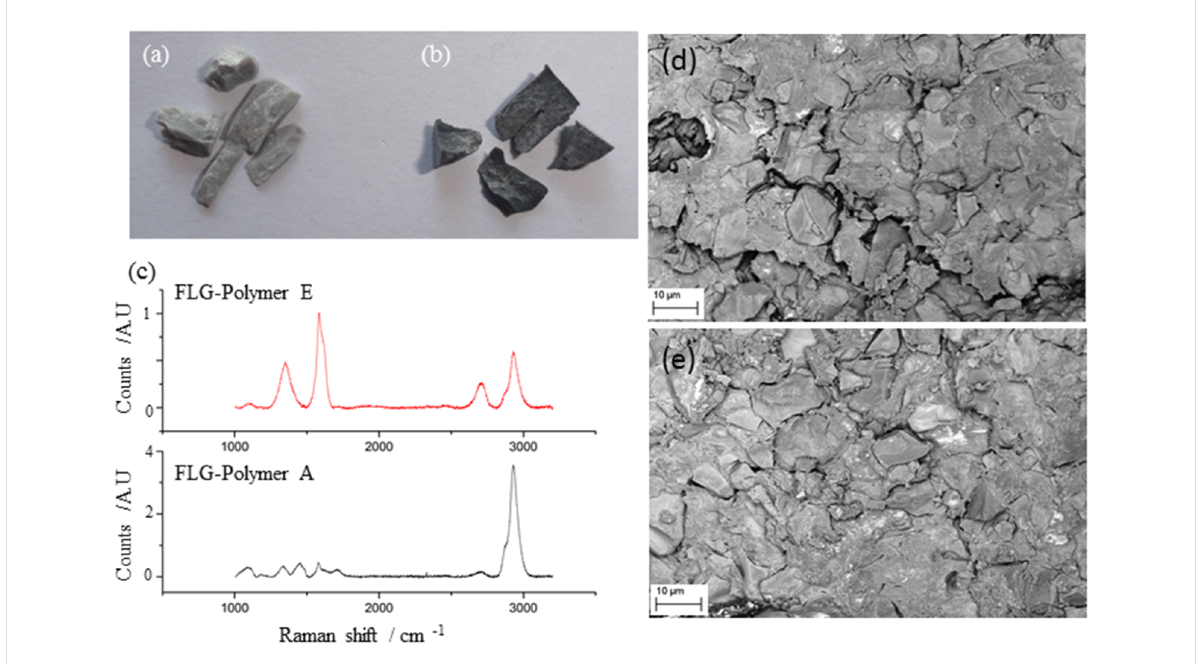
Figure 3: a) GI composite after strength testing made from FLG-polymer A, b) GI composite after strength testing made from FLG-polymer E, c) Raman spectra of GI composite made from FLG-polymer E and GI composite made from FLG-polymer A – both at 514 nm, d) SEM overview of fracture surface of GI composite made from FLG-polymer A, e) SEM overview of fracture surface of GI composite made from FLG-polymer